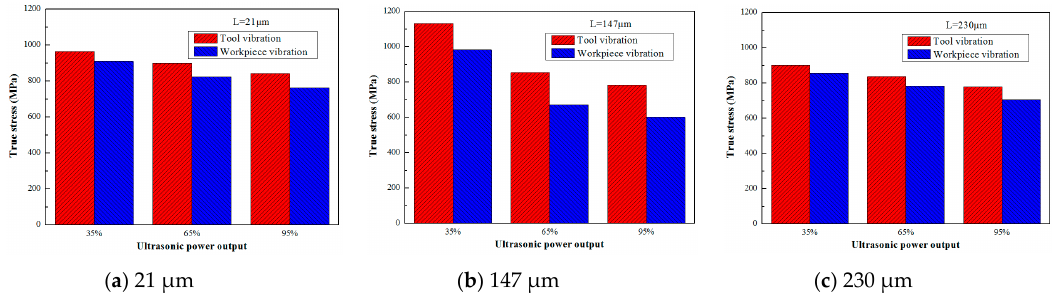
Figure 5. True stress and true strains with different ultrasonic power outputs.